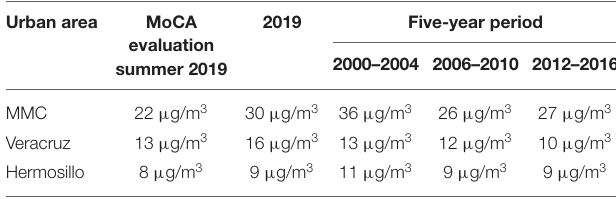
TABLE 1 | Summary of the 24-h PM 2.5 averages in µ g/m 3 for the 2019 period of MoCA evaluations and the annual periods: 2000-2004; 2006-2010, and 2012-2016 for MMC, the City of Hermosillo and the Port of